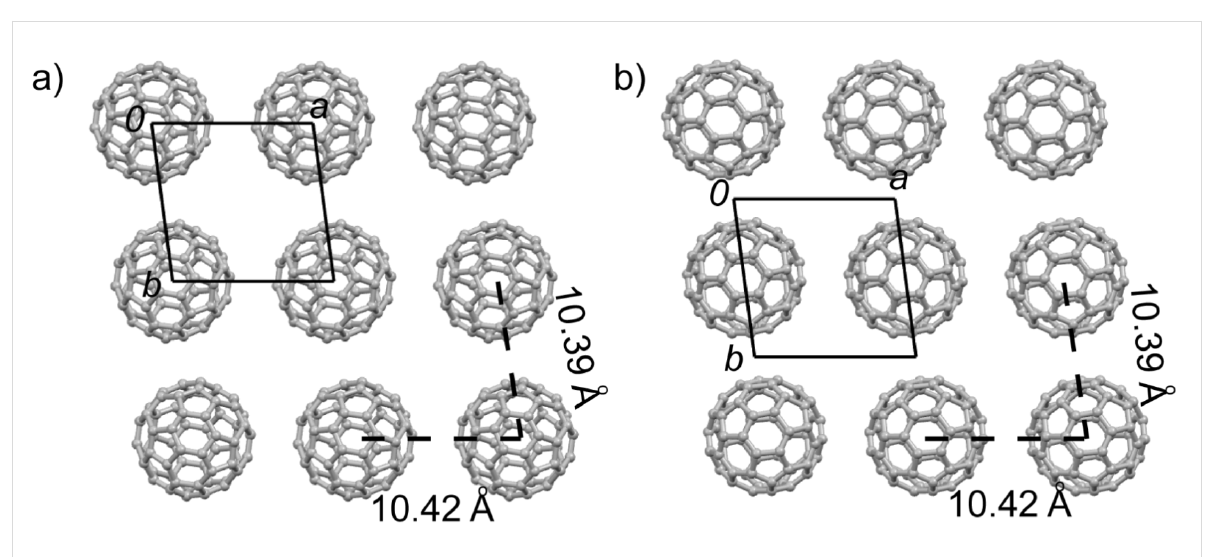
Figure 3: Packing motifs of C 60 molecules A (a) and B (b) of 1 ·(C 60 ) 2 ·(CS 2 ) 2 in the crystallographic ab -plane with the center-to-center distance between the neighboring C 60 molecules shown.